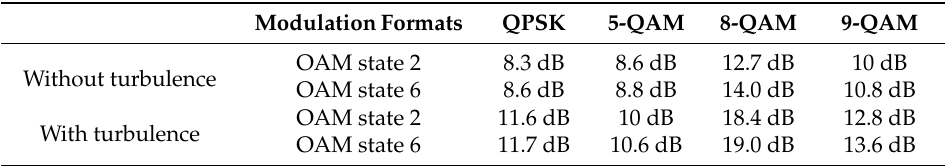
Table 1. Minimum OSNR requirements at BER of 10 − 4